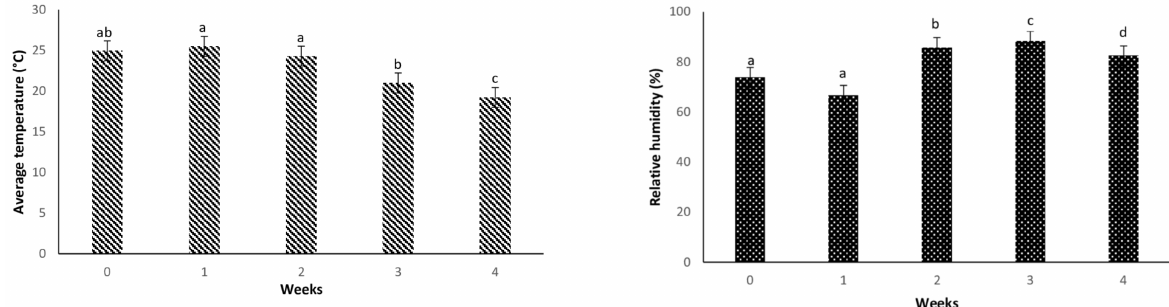
Figure 3. Ambient air temperature and relative humidity data recorded weekly every 30 min. Means followed by different letters are significantly different ( p < 0.05) between weeks using the SNK test. Table 1. Weekly ectophytic persistence of I. javanica ; and evaluation of total CFUs and adhered spore density of washed spores; and pf185 after spraying.